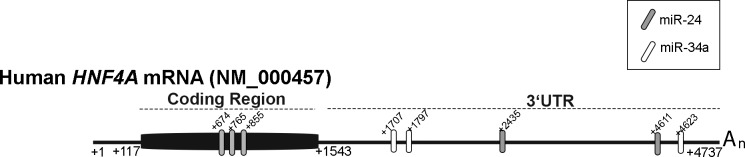
Schematic diagrams of human mRNA of HNF4A.[27,28,30]